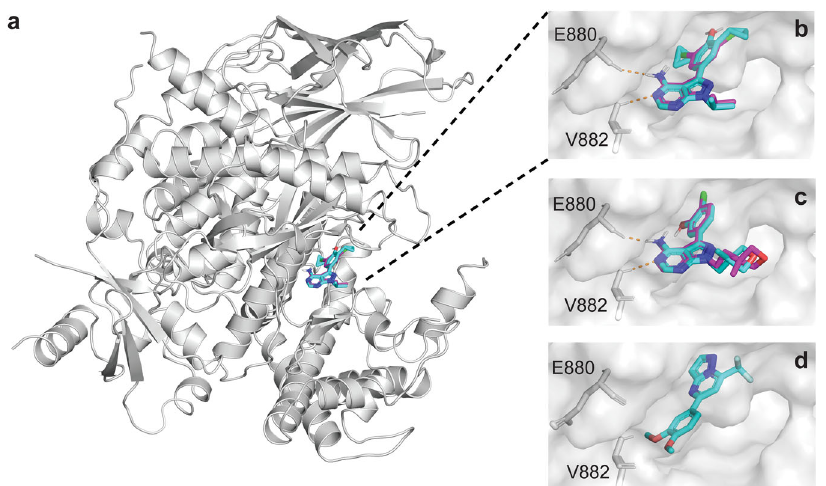
Fig. 7 | Docking poses of novel PI3K γ inhibitors. a Global view of PI3K γ (PDB ID: 3ENE) with stick models of molecules 21 (blue) and 22 (magenta) docked into the activesiteofPI3K γ . b Close-upviewofthesuggestedbindingposesofmolecules 21